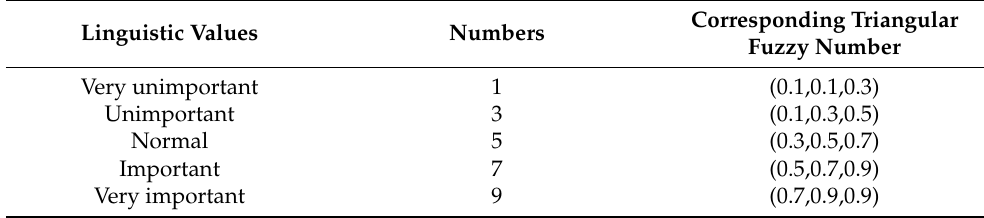
Table 3. Linguistic scale with triangular fuzzy number.